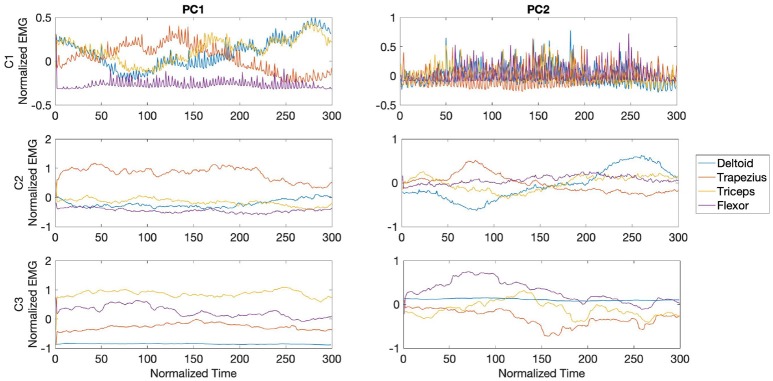
Waveforms showing the two principal components of muscle activation across the deltoid (blue), trapezius (orange), triceps (yellow), and wrist flexor (purple) muscles for cellists C1-3 in the transition phase (middle panel in Figure 8). Each panel shows the activation pattern centered around bow onset (150 ms).